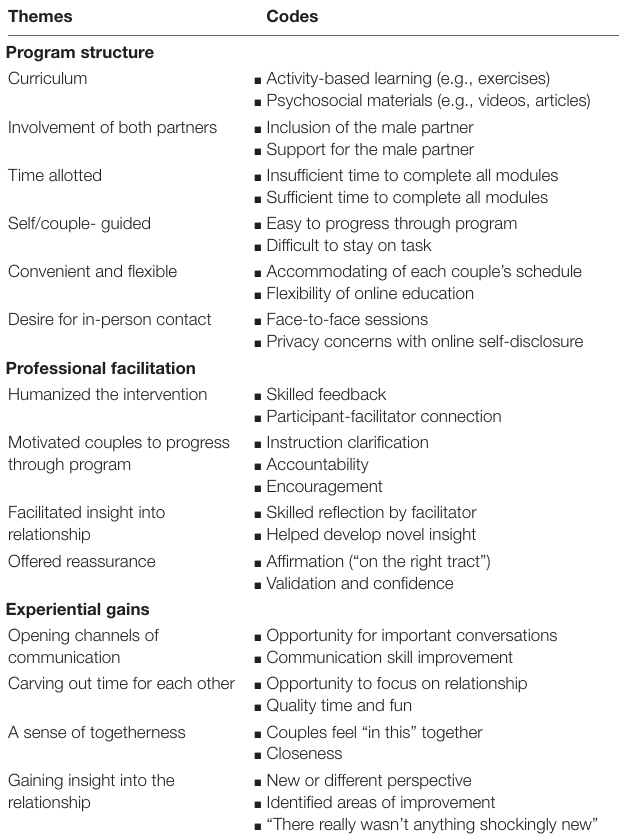
TABLE 4 | Themes and codes from analysis of the Couplelinks treatment satisfaction questionnaire. Themes Codes Program